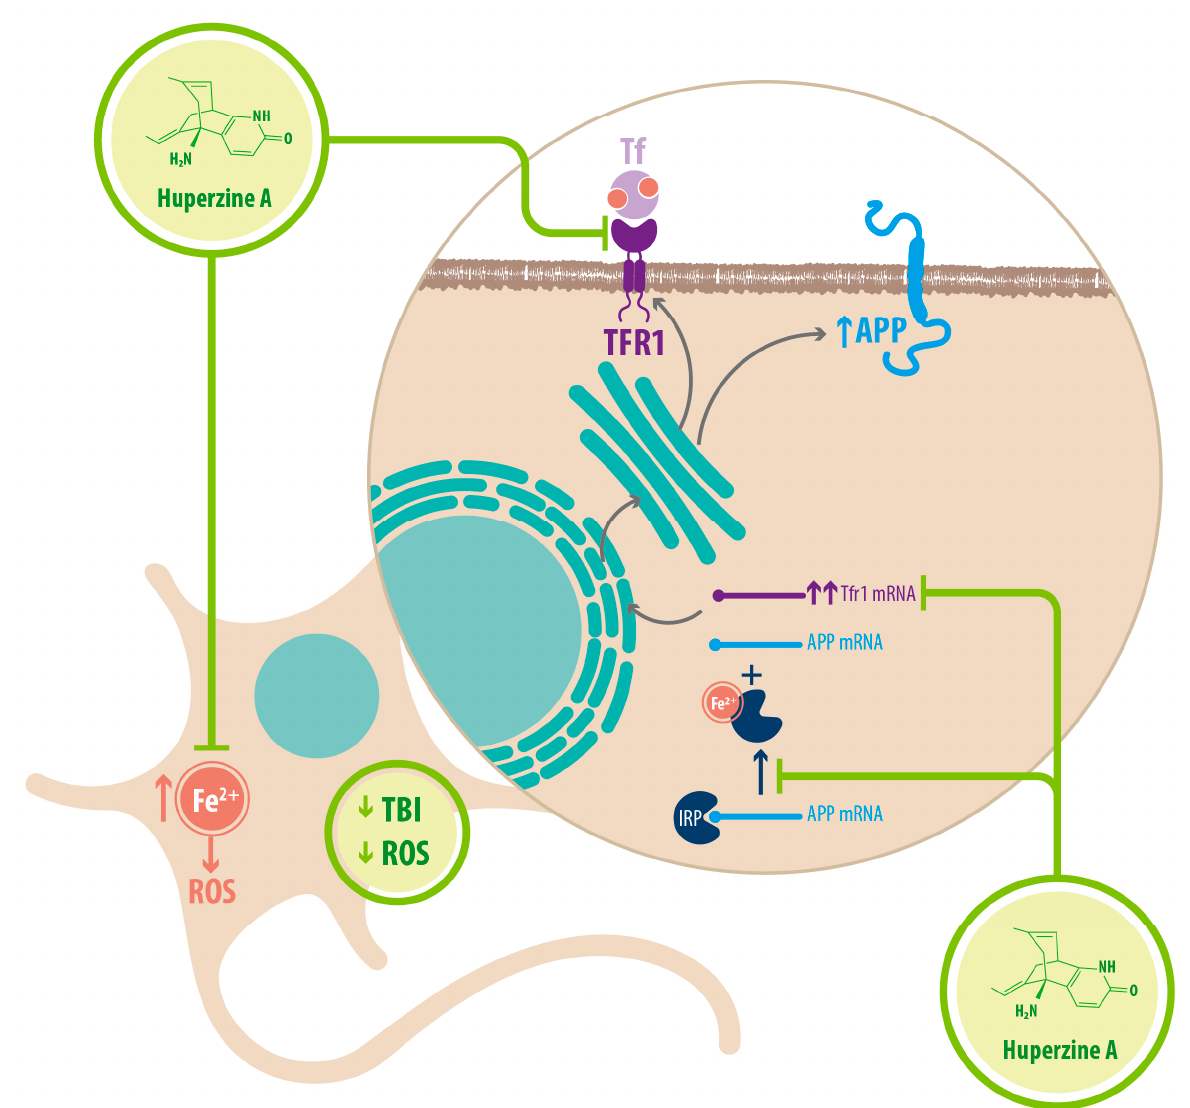
Figure 6. HupA regulates Fe 2+ homeostasis. HupA prevents the accumulation of Fe 2+ inside the neurons. It might act as a chelator, while also downregulating the expression of TFR1 and preventing Fe 2+ uptake into the cell. By reducing Fe 2+ concentration inside the neuron, HupA reduces APP translation. Fe 2+ binds the IRP, releasing it from APP mRNA which can then get translated. In the presence of HupA, Fe 2+ concentration drops, and less IRP is released, meaning less APP is translated. HupA indirectly reduces ROS through all these mechanisms (TFR1: transferrin receptor 1; Tf: transferrin; TBI: transferrin bound iron; ROS: reactive oxygen species; APP: amyloid precursor protein; IRP: iron regulatory protein).